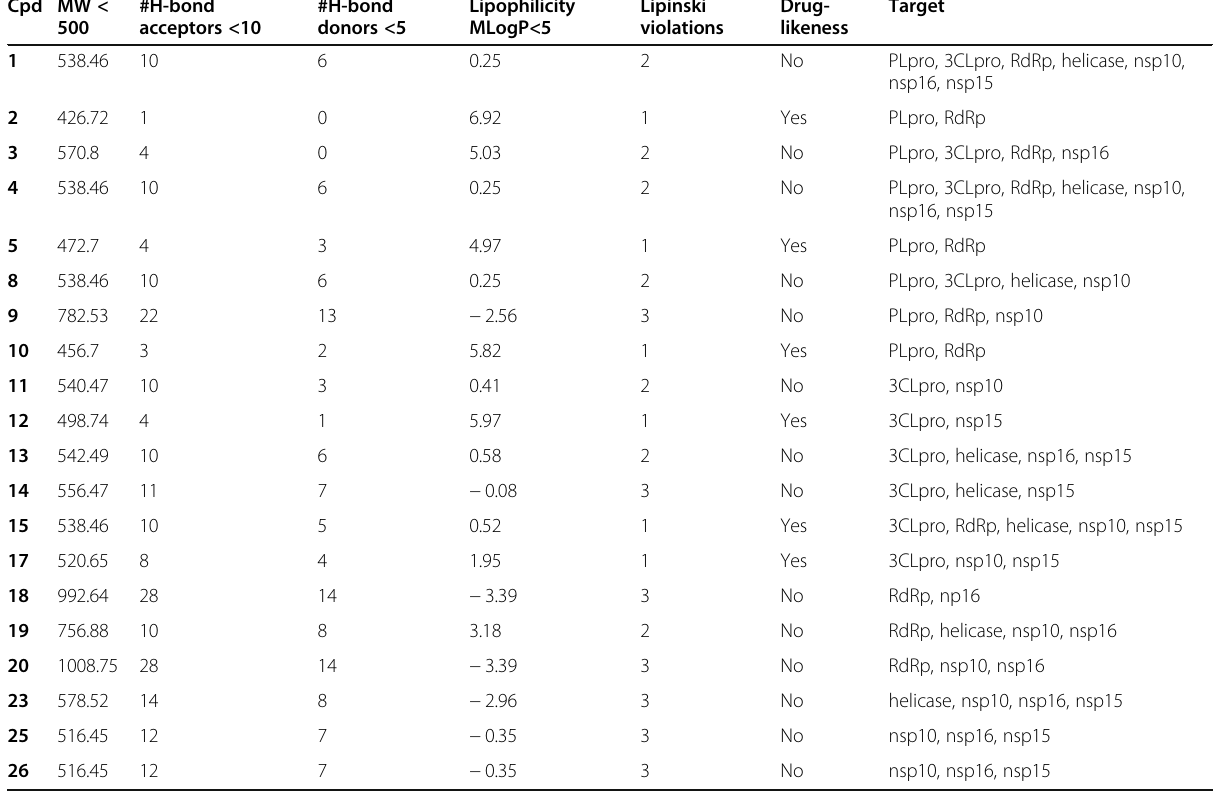
Table 5 Druggability of top, multi-targeting compounds according to Lipinski ’ s rule of five Cpd MW <